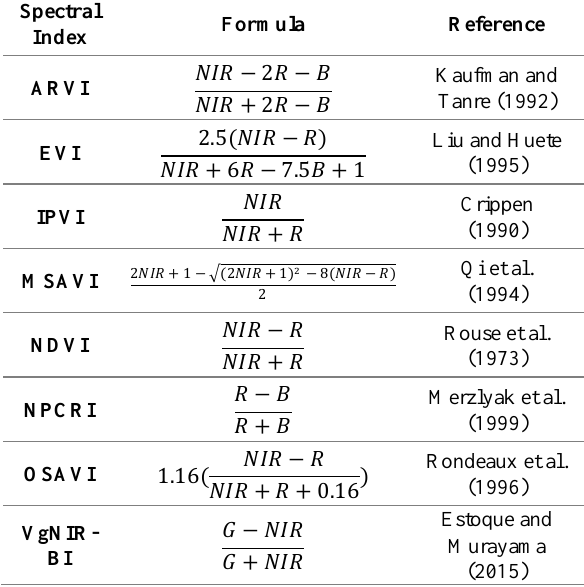
Table 1. Spectral indices used in the